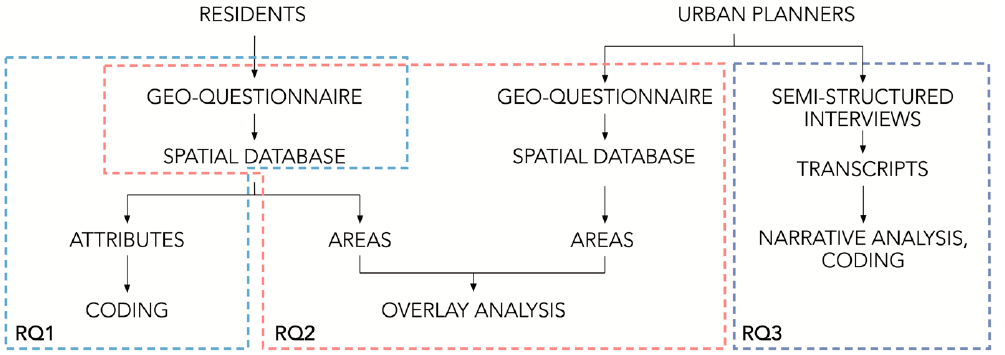
Figure 1. Research